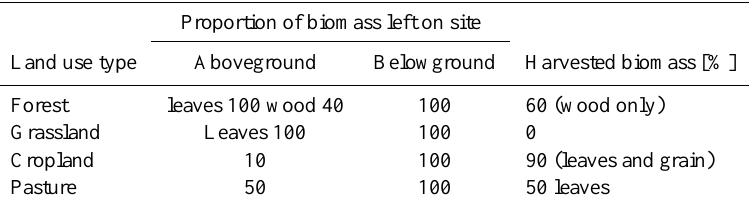
Table 1. Fate of biomass after land cover conversion or harvest in simulations of model including effects of land cover conversion on carbon cycle (after Zaehle et al., 2007).